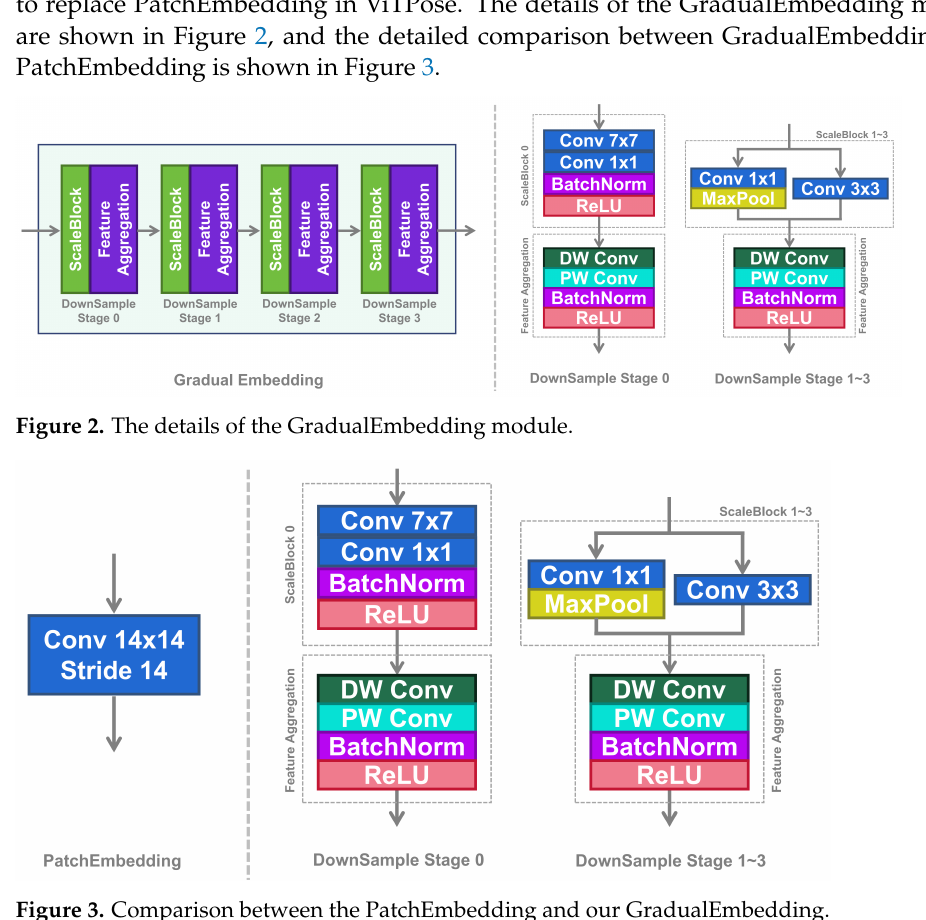
Figure 3. Comparison between the PatchEmbedding and our